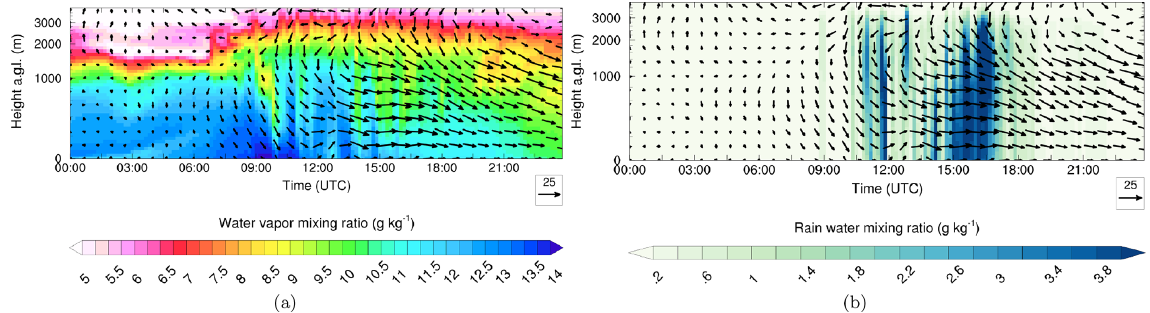
Figure 4. Time–height cross section of (a) water vapour mixing ratio (gkg − 1 ) and (b) rain water mixing ratio (gkg − 1 ) at grid point 13.2 ◦ E and 52.85 ◦ N (close to the maximum heavy precipitation location, near black dot in Fig. 3) simulated by the WRF model. The displayed period is 00:00 until 23:45UTC on 29 June 2017. Arrows denote the horizontal wind speed (ms − 1 , see lower right of the plots for a length indicating 25ms − 1 ) and direction at the different altitudes. Altitude is above ground level